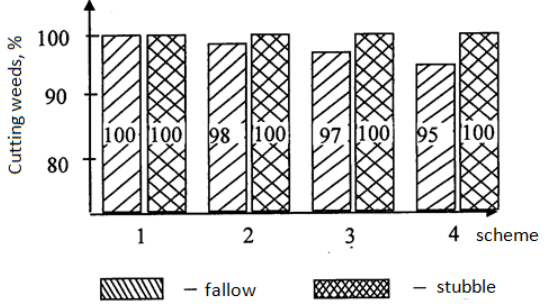
Figure 8. Influence of the technological scheme of the tool on the quality of cutting weeds